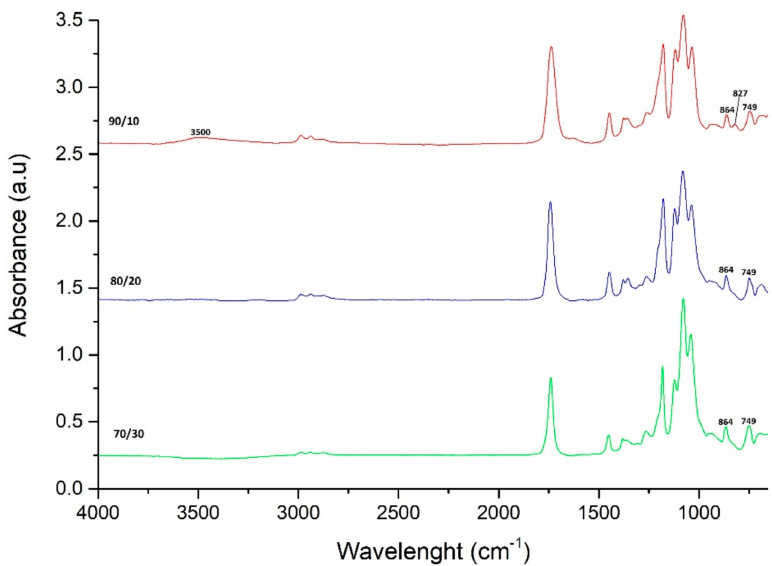
Figure 3. FTIR spectra of PLA- co -PPGDGE with different monomer ratio L -lactide/PPGDGE.